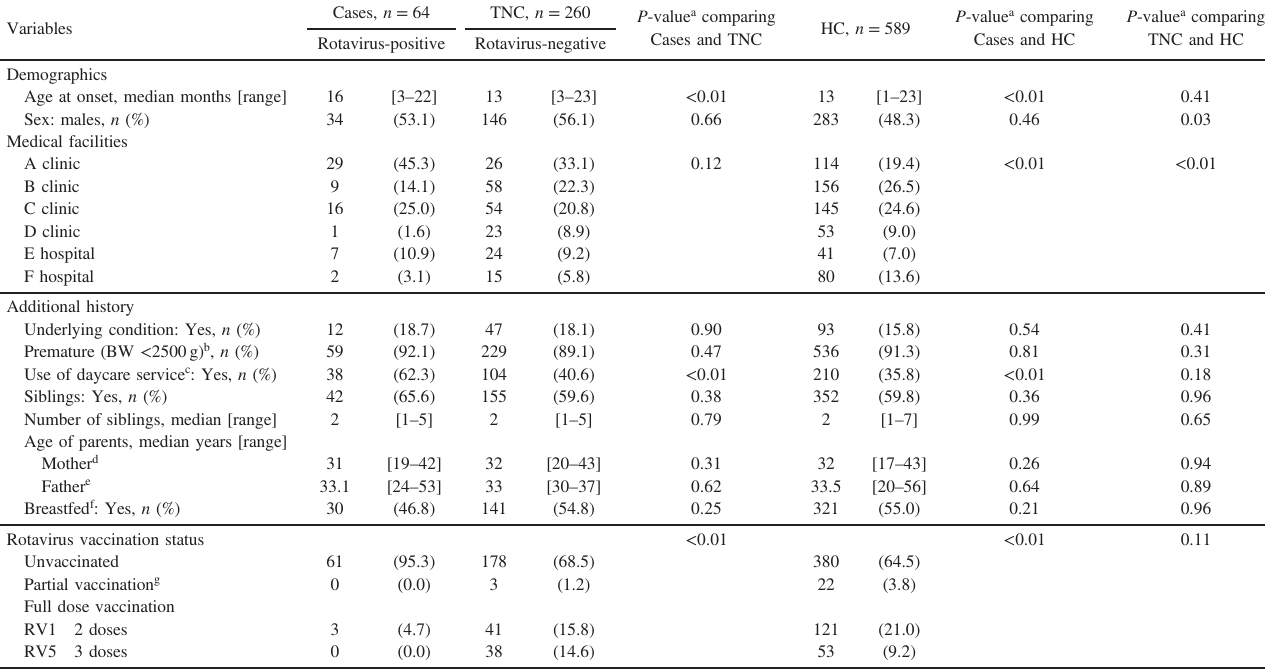
Table 1. Baseline characteristics of cases and controls Variables